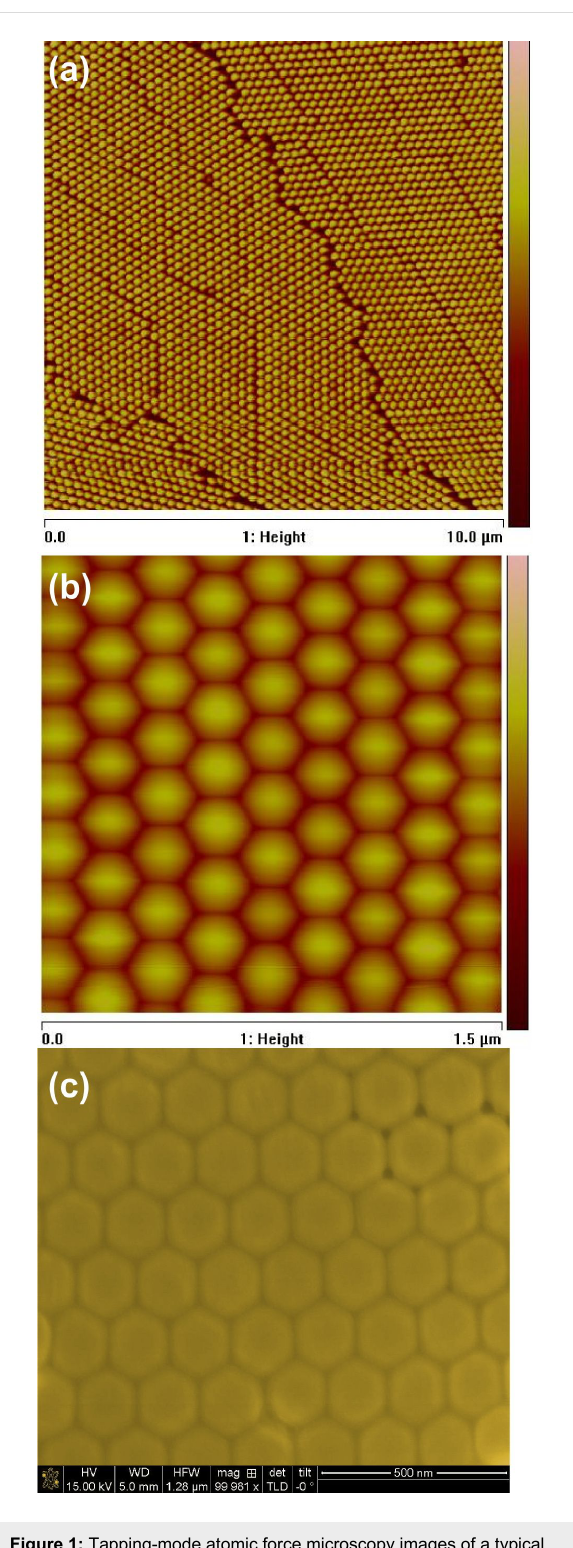
Figure 1: Tapping-mode atomic force microscopy images of a typical monolayer, with the particle diameter (and the inter-particle distance) of 200 nm on (a) a large scale and (b) a small scale. Scanning elec- tron microscopy image of the sample (c) shows that the nanoparticle array has a nearly perfect close-packed hexagonal